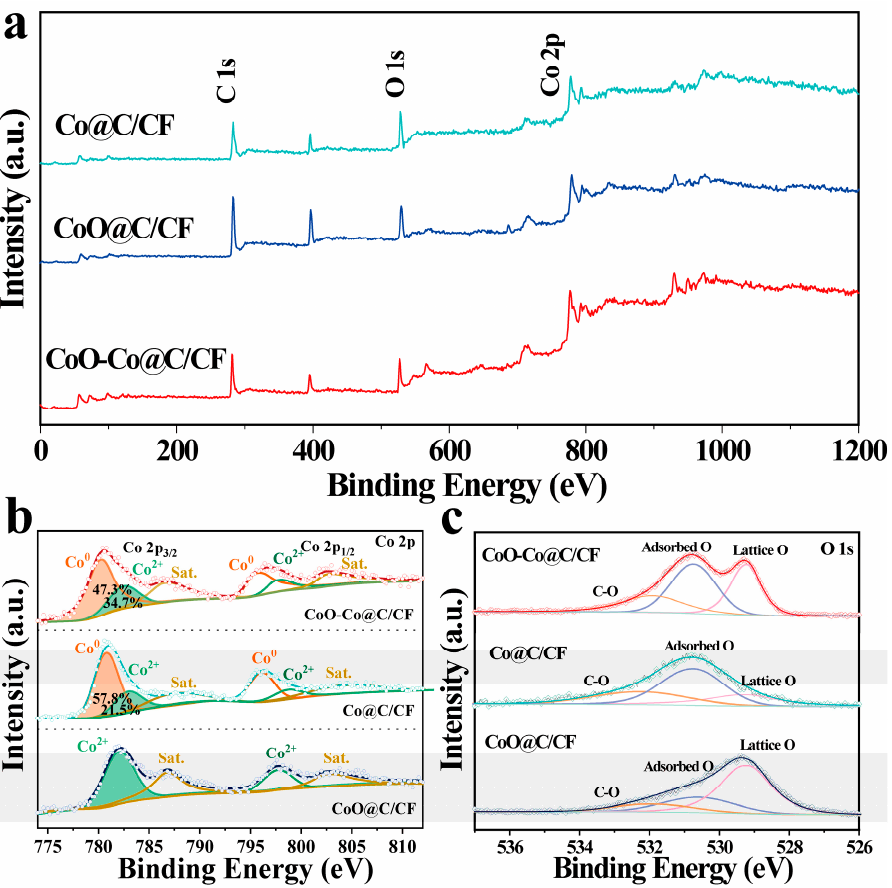
Figure 2. XPS survey spectra ( a ), Co 2p spectra ( b ) and O 1s spectra ( c ) of CoO–Co@C/CF, Co@C/CF, and CoO@C/CF. and